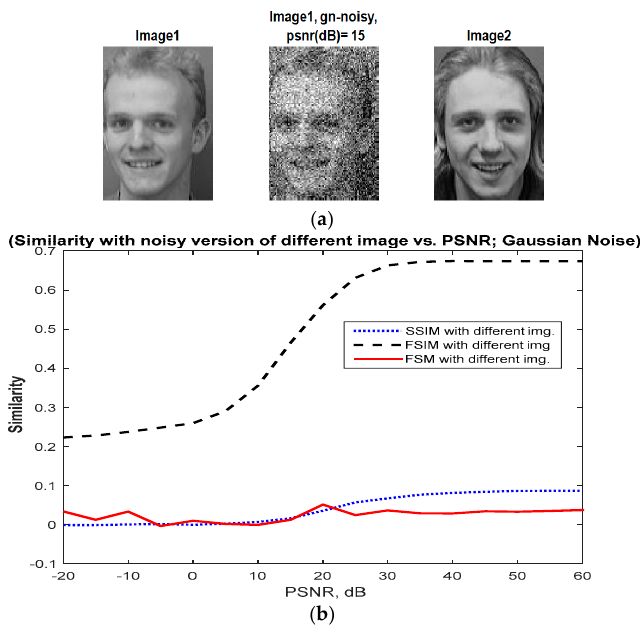
Figure 18. Performance of similarity measures using dissimilar images under Gaussian noise; ( a ) Above: The test images; ( b ) Performance of SSIM, FSM and FSIM under Gaussian noise.